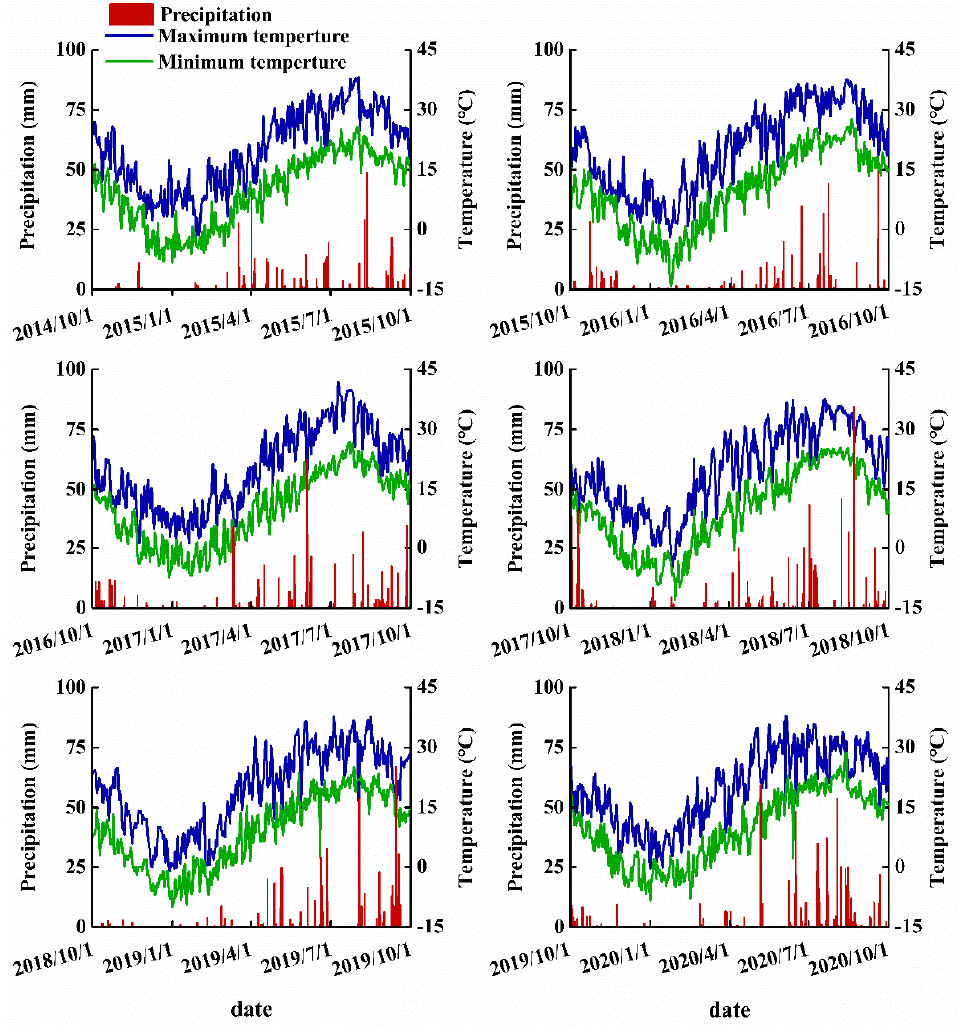
Figure 1. Daily maximum and minimum temperatures and precipitation during 2014–2020. Source: National Meteorological Observing Station in Yangling, Shaanxi Province, China.